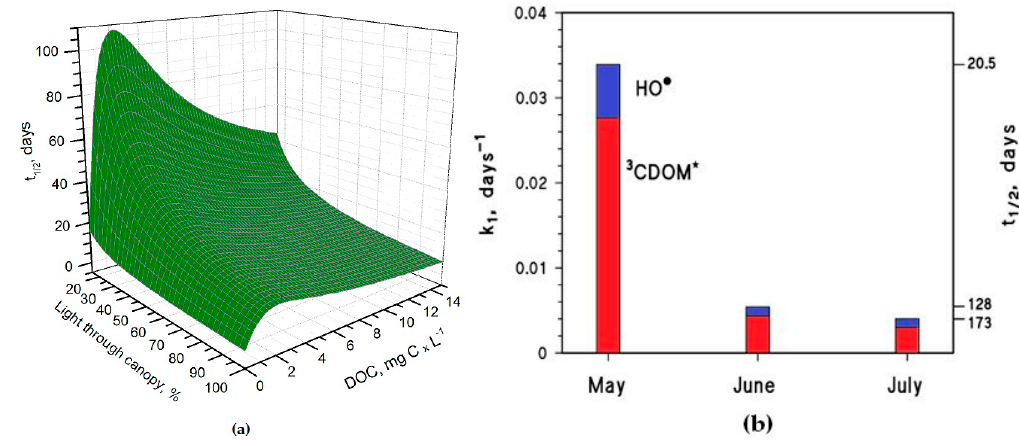
Figure 3. ( a ) Photochemical half-life time of H 3 AsO 3 in rice-field water, as a function of the DOC and of light transmittance through the rice canopy. Other conditions: 5 cm depth, 0.1 mM NO 3 − , 1 μ M NO 2 − , 1 mM bicarbonate, 10 μ M carbonate, and May sunlight. ( b ) Pseudo-first-order rate constant of H 3 AsO 3 photooxidation in the period from May to July. The corresponding half-life times ( t 1/2 = ln2 ( k 1 ) − 1 ) are also reported in the right Y-axis. Water conditions: 5 cm depth, 7 mg·C·L − 1 DOC, 0.1 mM NO 3 − , 1 μ M NO 2 − , 1 mM bicarbonate, and 10 μ M carbonate. Transmittance values through the rice canopy are reported in the main text. The days are referred to average irradiance conditions occurring at mid latitude in, where relevant, mid-May, mid-June, and mid-July.